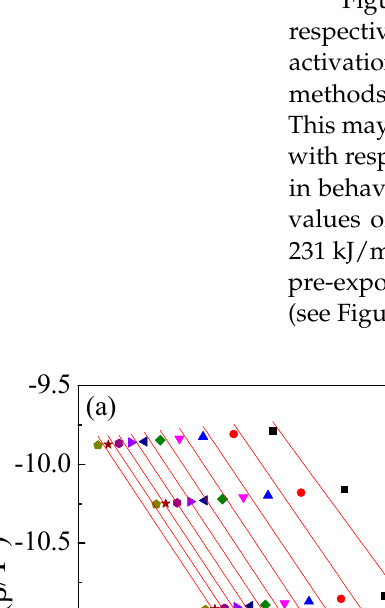
Figure 7. Temperature dependence of ( a ) the conversion, α , and ( b ) the conversion rate, da/dt, for the EPDM host composite sample.